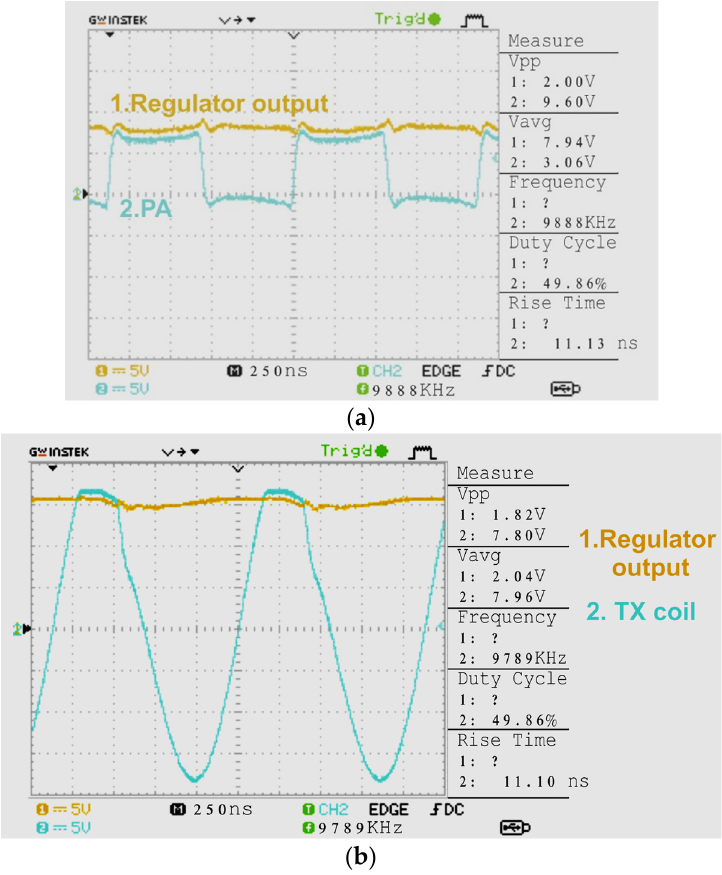
Figure 9. Measurement results. ( a ) Measured regulator voltage and PA waveform by a digital oscilloscope. Yellow line shows the rectifier output voltage and blue line shows the PA output voltage at 0° rotation orientation. ( b ) TX coil voltage blue line and regulator output voltage for 90° rotated RX coil in yellow line.